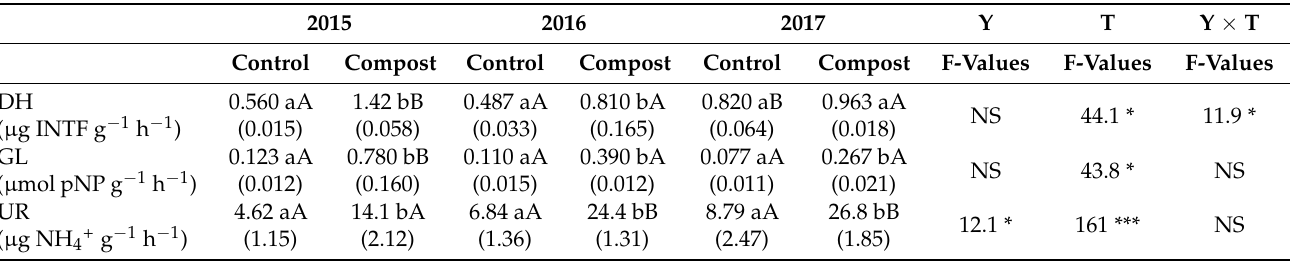
Table 2. Effects of different management systems on soil enzyme activities (0–10 cm depth). Mean value and standard error of 3